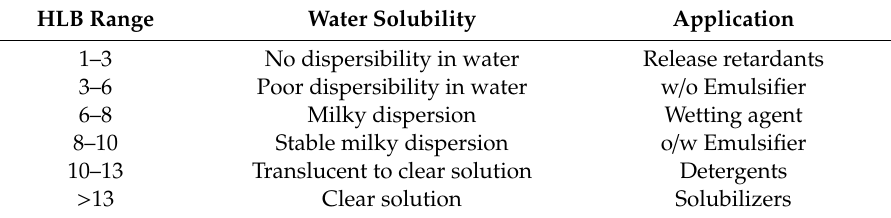
Table 6. Application of surfactant based on the HLB range